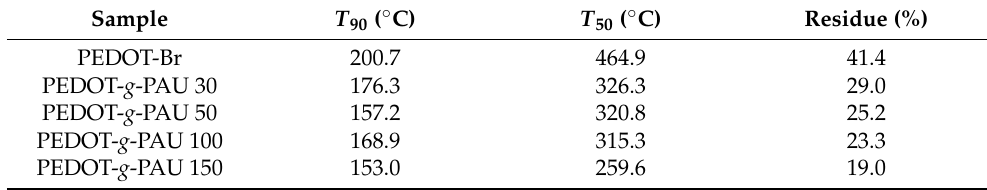
Figure 8. TG curves of PEDOT-Br macroinitiator and PEDOT- g -PAU graft copolymer. Table 3. Thermal properties of PEDOT-Br macroinitiators and copolymers PEDOT- g